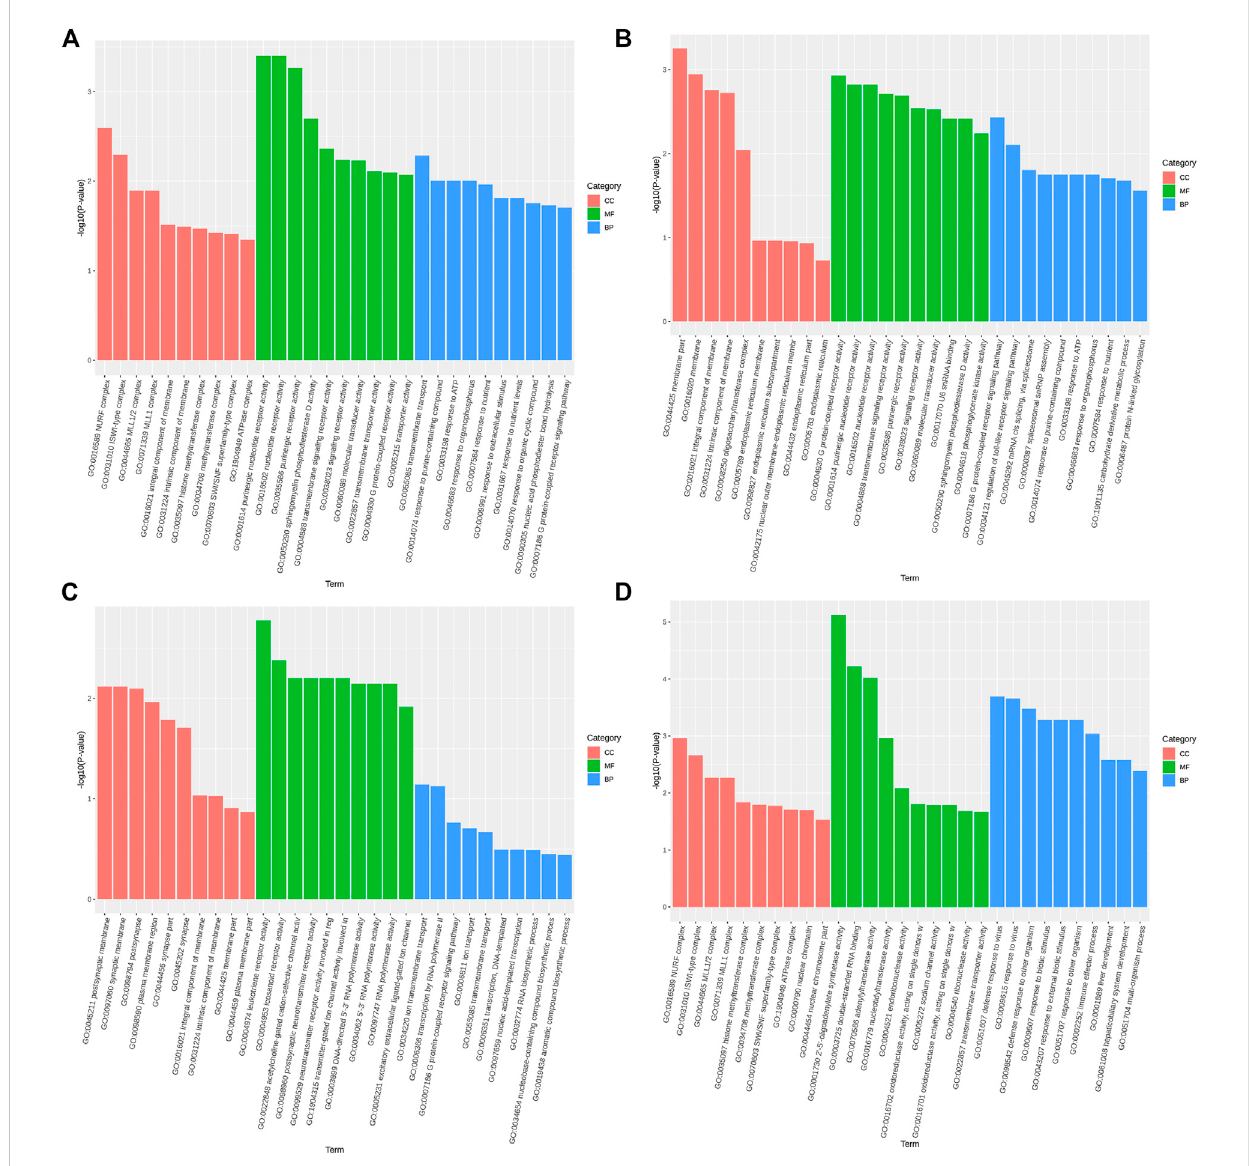
FIGURE 4 Top 10 signi fi cantly enriched GO terms of cellular component (CC), molecular function (MF), and biological process (BP). (A) . Body height, (B) . Body length, (C) . Chest circumference, (D) . Shin